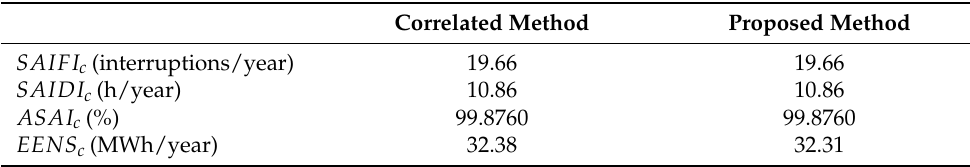
Table 10. Reliability indices obtained for a real distribution